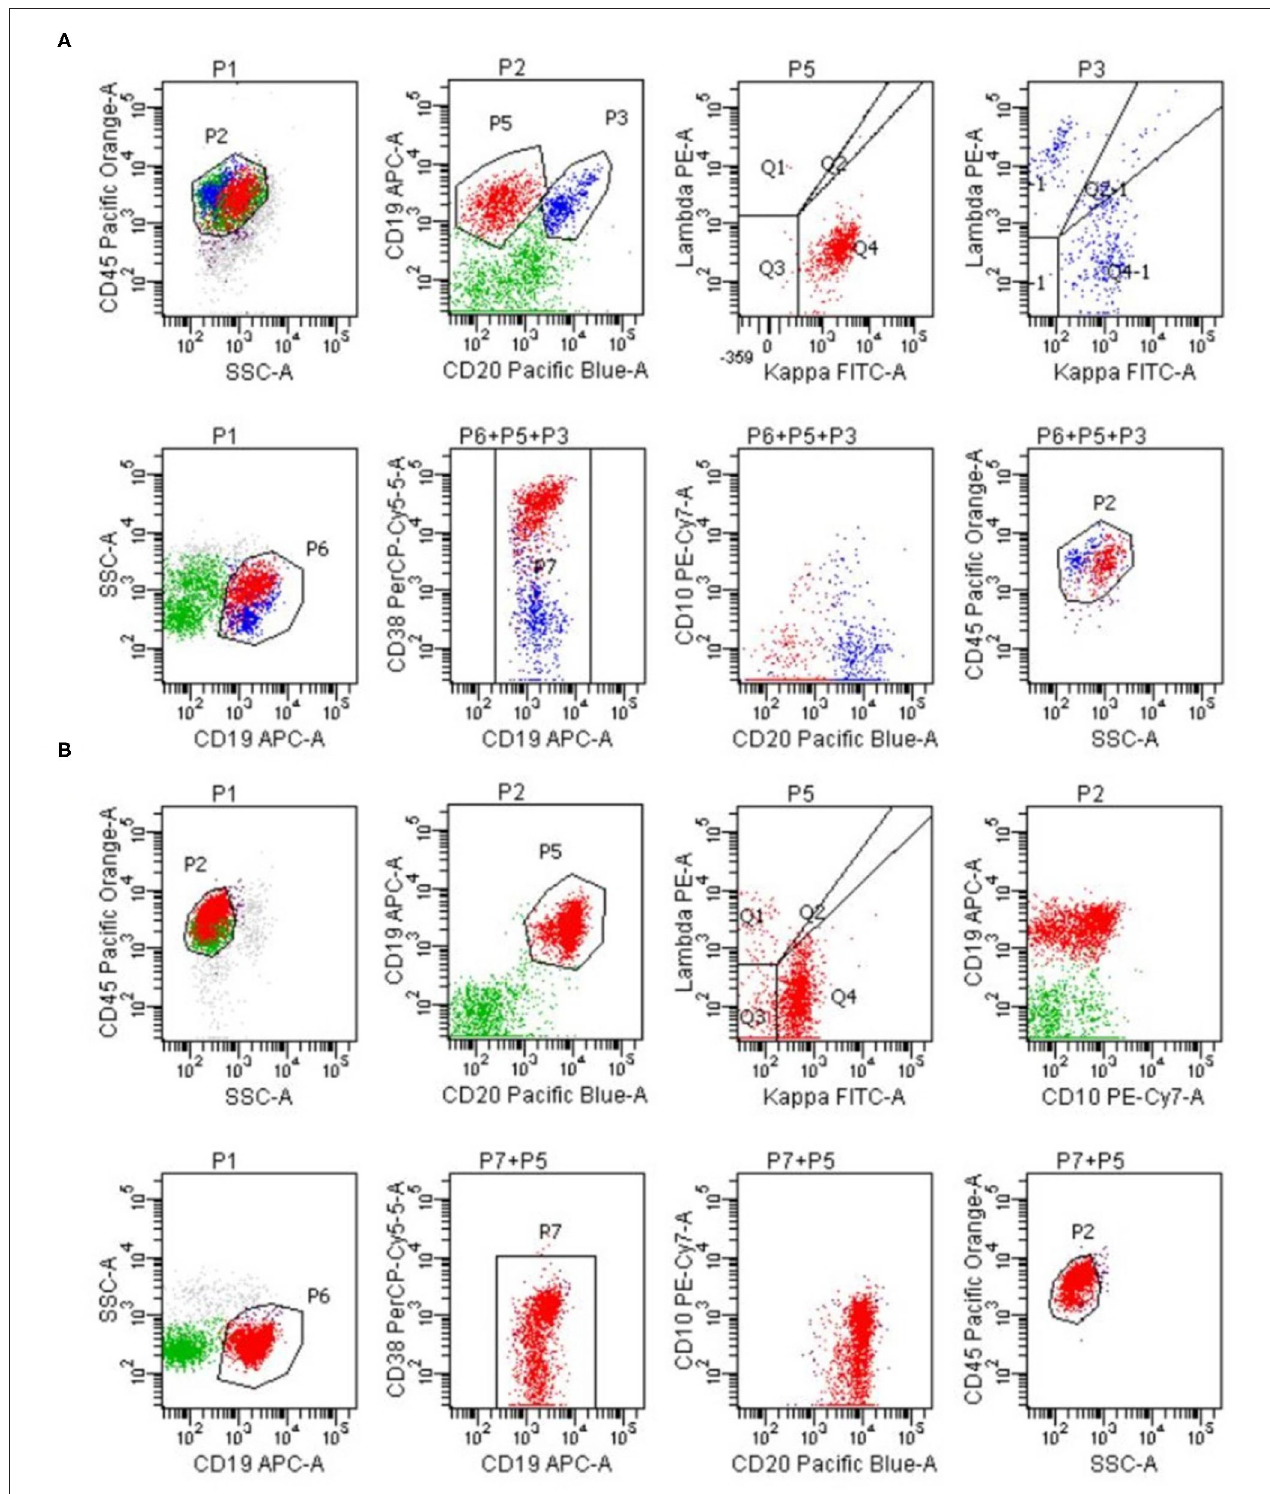
FIGURE 2 | (A) The flow cytometry showed that ∼ 23.9% of all the lymphocytes (red cell population) expressed CD19, CD20, CD38, kappa, and did not express lambda, CD10. (B) The flow cytometry of the ESD sample showed that ∼ 39.5% of all the lymphocytes (red cell population) expressed CD19, CD20, kappa, CD38 (partial), and did not express lambda,